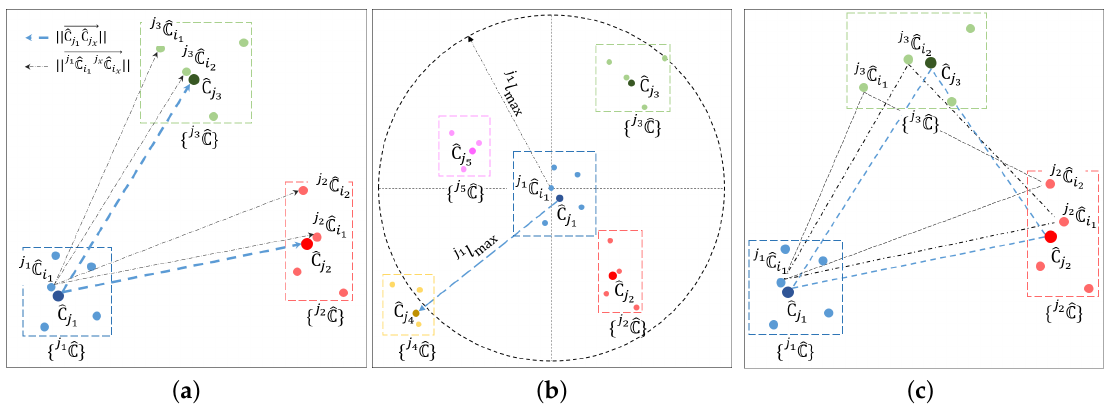
Figure 7. Demonstration of the three geometric conditions, where different candidate sets are indicated by different colors: ( a ) length condition, ( b ) inclusion condition, and ( c ) triangular condition.